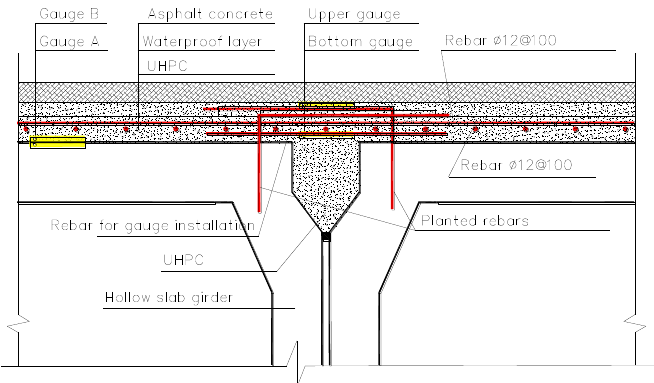
Figure 9. Gauge arrangement plan.